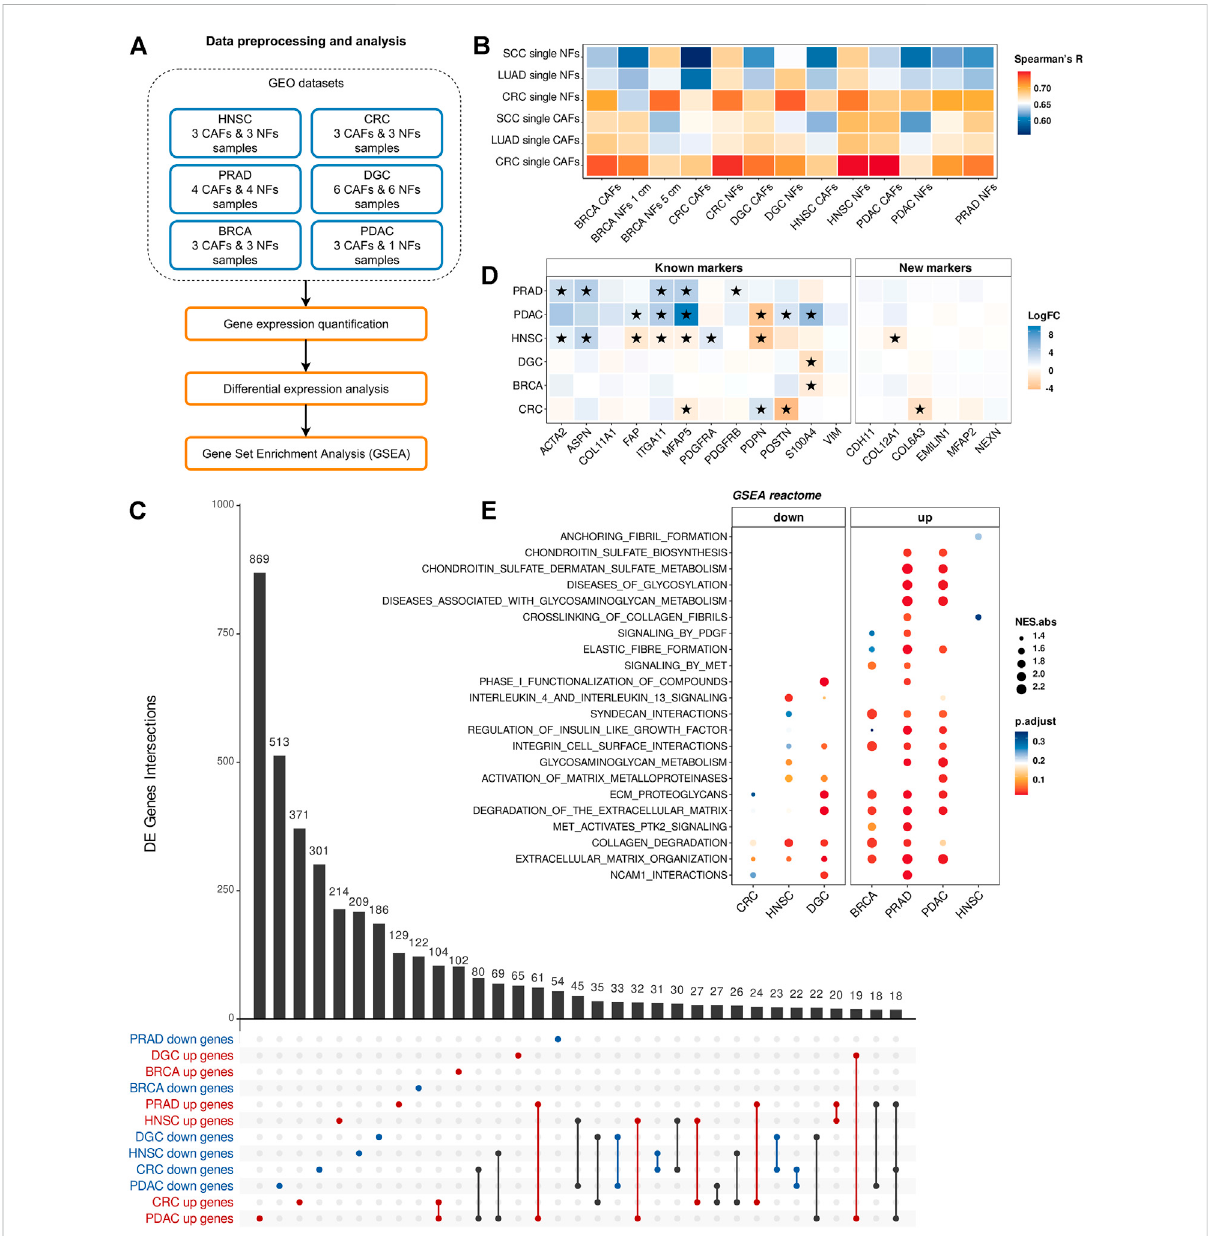
FIGURE 3 Comparison of gene expression between CAFs and NFs within the bulk-CAFs-NFs approach. (A) Work fl ow for comparing gene expression between CAFs and NFsby analyzing bulk RNA-seq data of fi broblastderived from thetumors and fi broblast derivedfrom non-malignant regions. (B) TheSpearman ’ scorrelationanalysis ofgeneexpressionpro fi lesofbulkandpseudo-bulkNFandCAFsamples(414CAFmarkergenes).Spearman ’ sR values are the medians of all pairwise Spearman ’ s correlation coef fi cient values between samples. (C) UpSet plot indicating the number of common differentially expressed genes between CAF and NF samples for all tumor type. Gene subset intersections are highlighted in red if these genesareup-regulatedinCAFs intheindicated tumortypes,inblueiftheyare down-regulated,inblack iftheyaredown-regulatedinsometypes of cancerandup-regulatedinothers. (D) HeatmapsshowingdifferencesinthegeneexpressionlevelinCAFsrelativetoNFs.Ontheleftisaheatmapfor common CAF marker genes, and on the right for our proposed CAF marker genes. Asterisks indicate signi fi cant differences in the expression ( | logFC | ≥ 1 and pvalue < 0.05). Blue = increased gene expression in CAFs comparedto NFs, orange = decreased gene expression in CAFs comparedto NFs. (E) DotplotsofGSEAresultsillustratingtheenrichmentofthecommonReactomepathwaygenesetsidenti fi edbytheenrichmentanalysisinthe sc-CAFs-NFsapproach.Typesoftumor:HNSC — headandnecksquamouscellcarcinoma,DGC — diffuse-typegastriccancer,BRCA — breastcancer, CRC — colorectal cancer, PRAD — prostate cancer, PDAC — pancreatic ductal